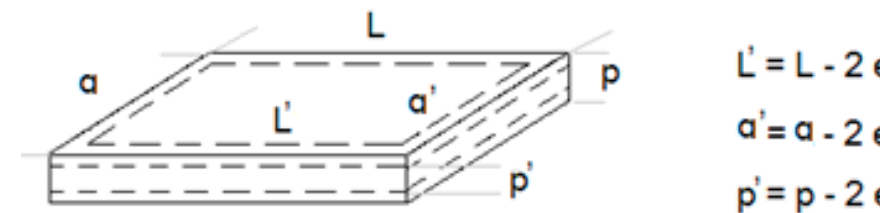
Figure 3. Theoretical representation of the thickness depletion, “e”, as a function of time, “t”, of a machining chip due to the aluminum–water reaction.